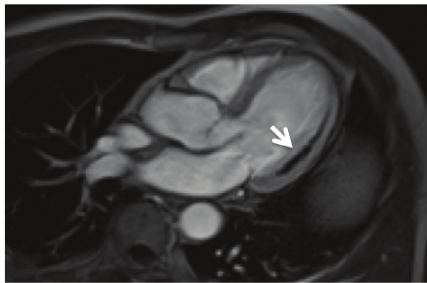
Figure 2: Microvascular obstruction (arrow) as shown by early gadolinium enhancement in a patient with acute myocardial infarc- tion (CMR